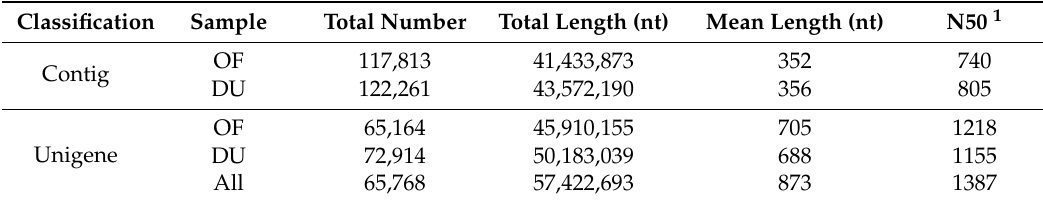
Table 2. Statistics of the assembly